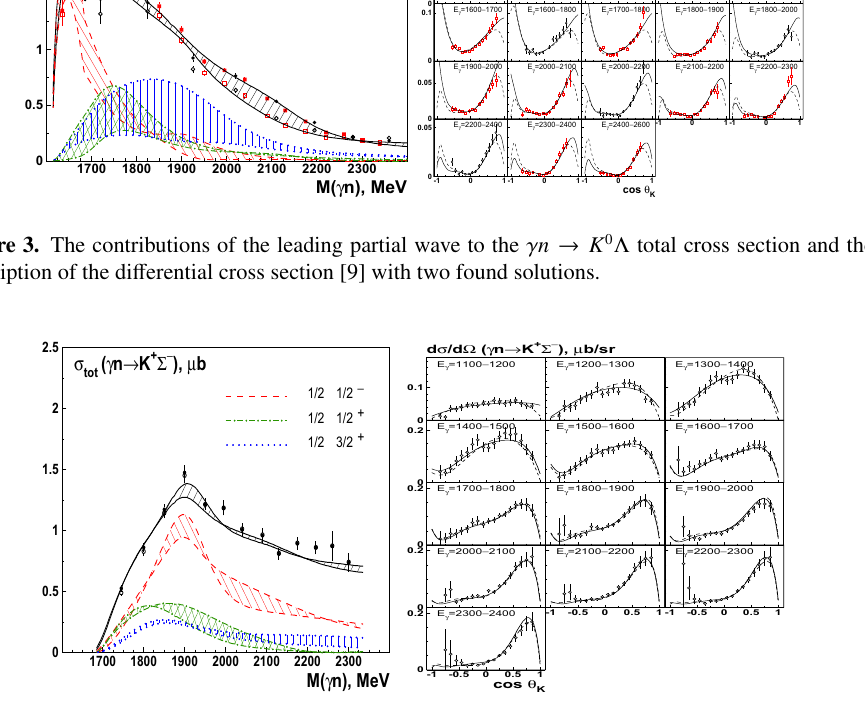
Figure 4. The description of the CLAS data on the γ n → K + Σ − di ff erential cross section